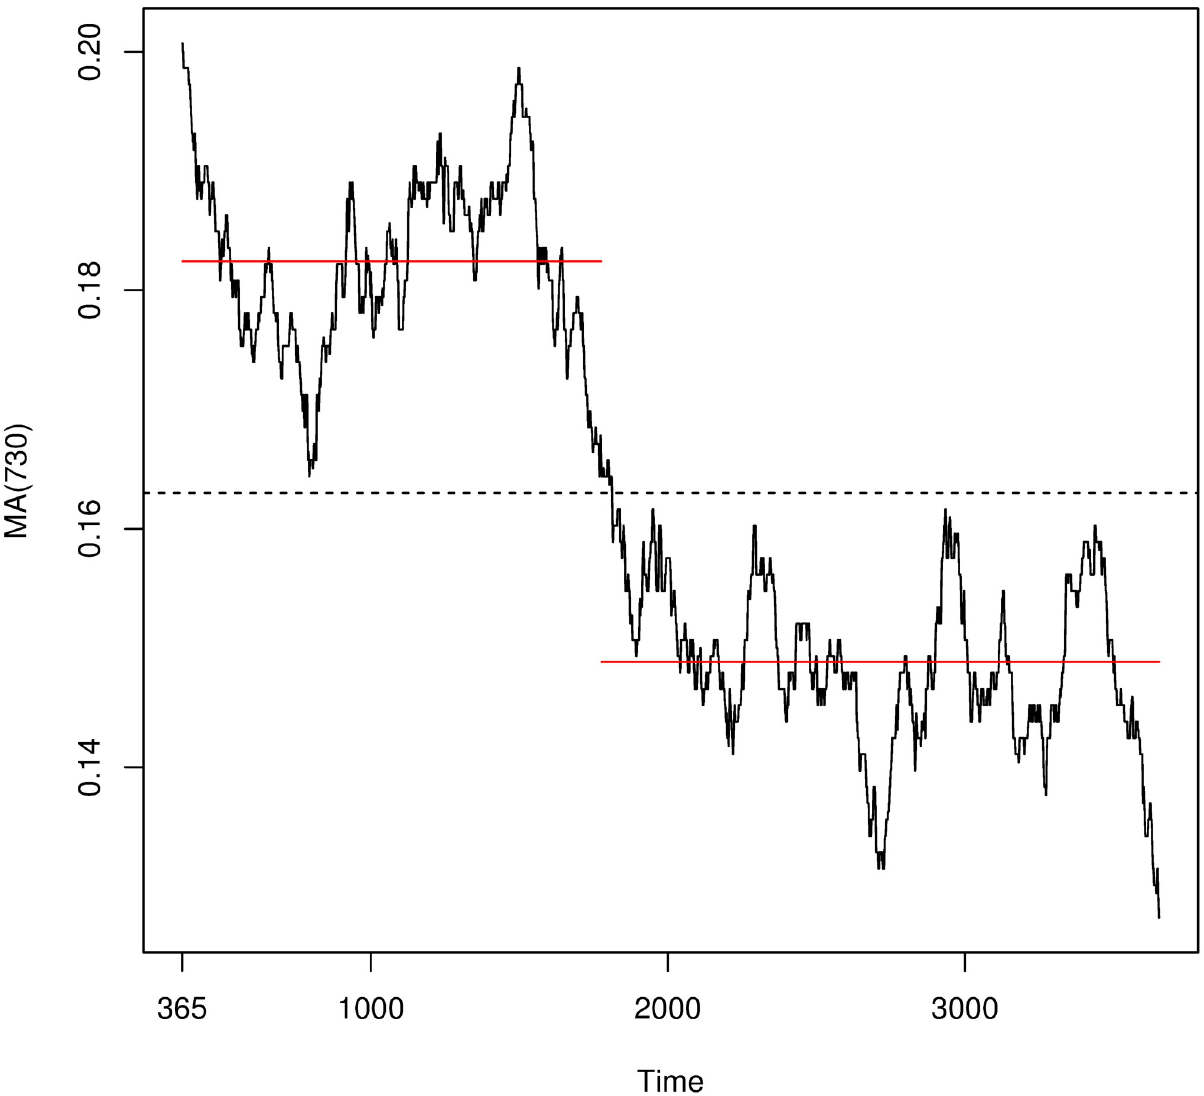
Fig 2. Plot of moving average of order 720 (y-axis) over time (x-axis). The red lines show the average before and after the change-point identified by the analysis. Please notice that the first and the last 365 days are not represented due to the Moving